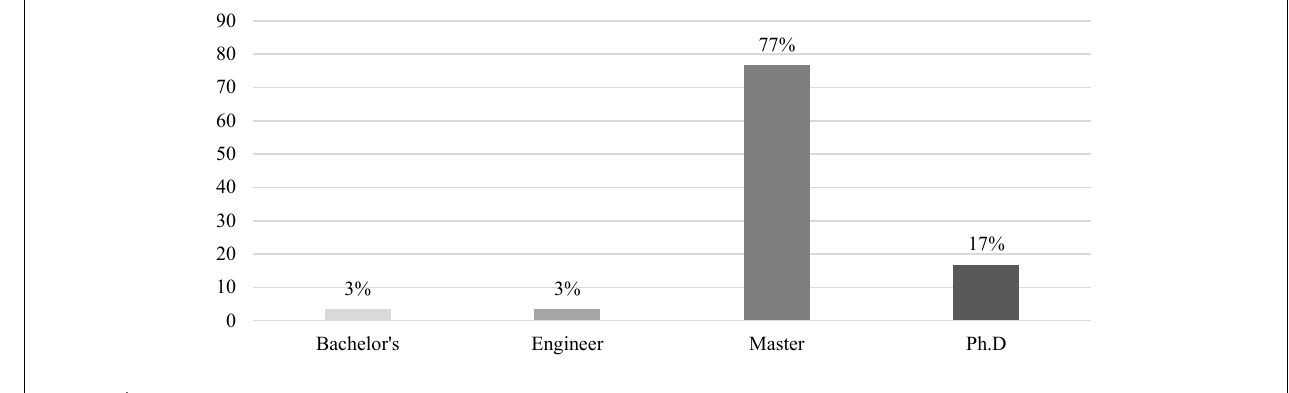
FIGURE 4 | Teachers’ knowledge and level of instruction.